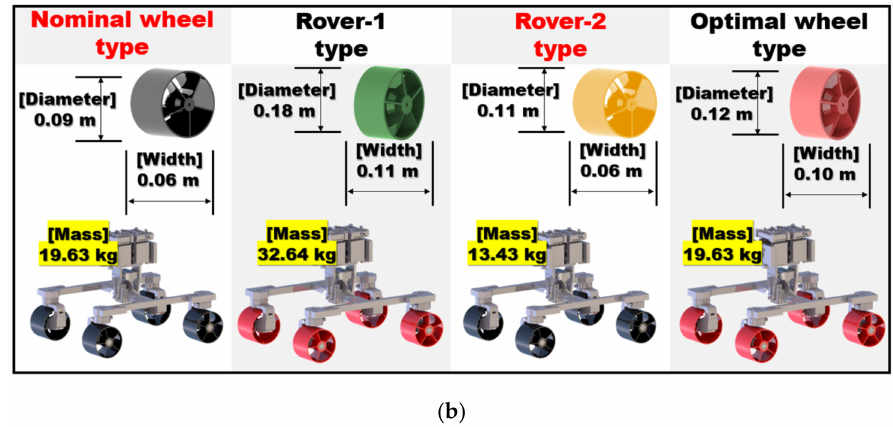
Figure 13. Schematic of scenario-based dynamic analysis for verifying the performance of optimal wheel type: ( a ) simulation scenarios; ( b ) di ff erent rover structure and wheel configurations.